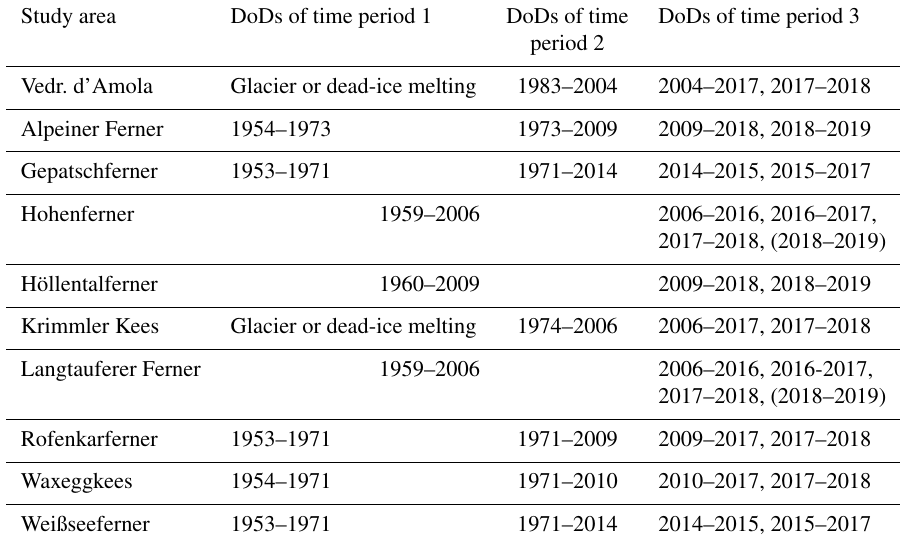
Table 4. DoDs used for the calculation of the erosion rates and their attribution to the defined time periods 1–3. Note that some moraine sections of the DoDs covering the entire forefields are affected by dead ice in some time periods (see Fig. 10), and for some moraine sections additional drone images were acquired (years in parentheses).